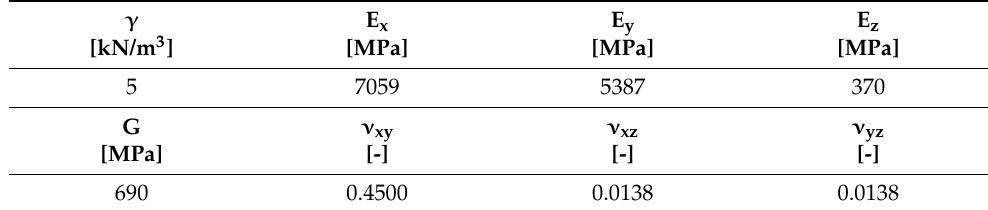
Figure 14. Modeling of the panel–panel and panel–curb connections. Table 8. Mechanical properties of the cross-laminated panel.